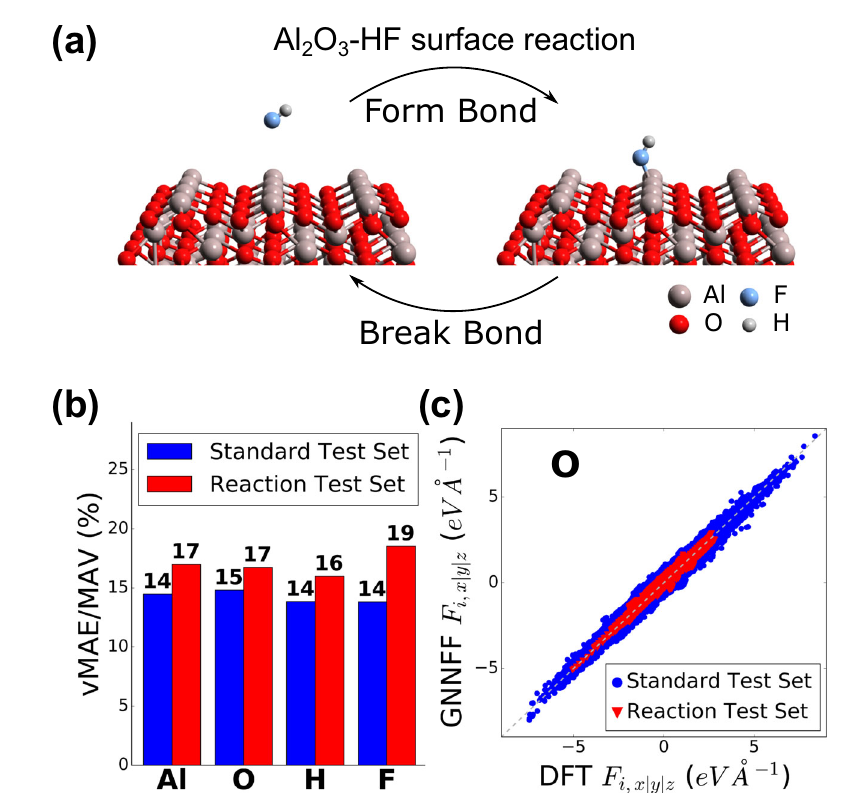
Fig. 3 Predicting the forces on atoms involved in surface reaction between Al 2 O 3 and HF. a Illustration of the Al 2 O 3 -HF surface reaction b Comparison of force predictive accuracies between standard and reaction test sets for all elements present in system. c GNNFF-predicted vs DFT-calculated force correlation plots of oxygen for both standard and reaction test